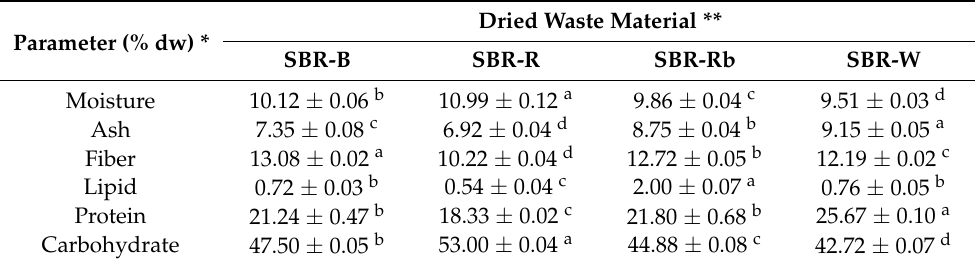
Values are expressed as the mean ± standard deviation. Means in the same column with different superscript letters are significantly different based on Tukey’s test ( p < 0.05). *: dw (dry weight); **: SBR obtained from solid media containing barley (B), white rice (R), Riceberry rice (Rb), and wheat